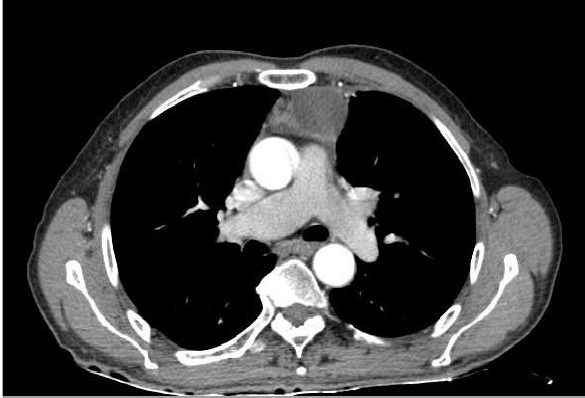
Figure 1. Chest CT scan with IV contrast “solid cystic mass in anterior